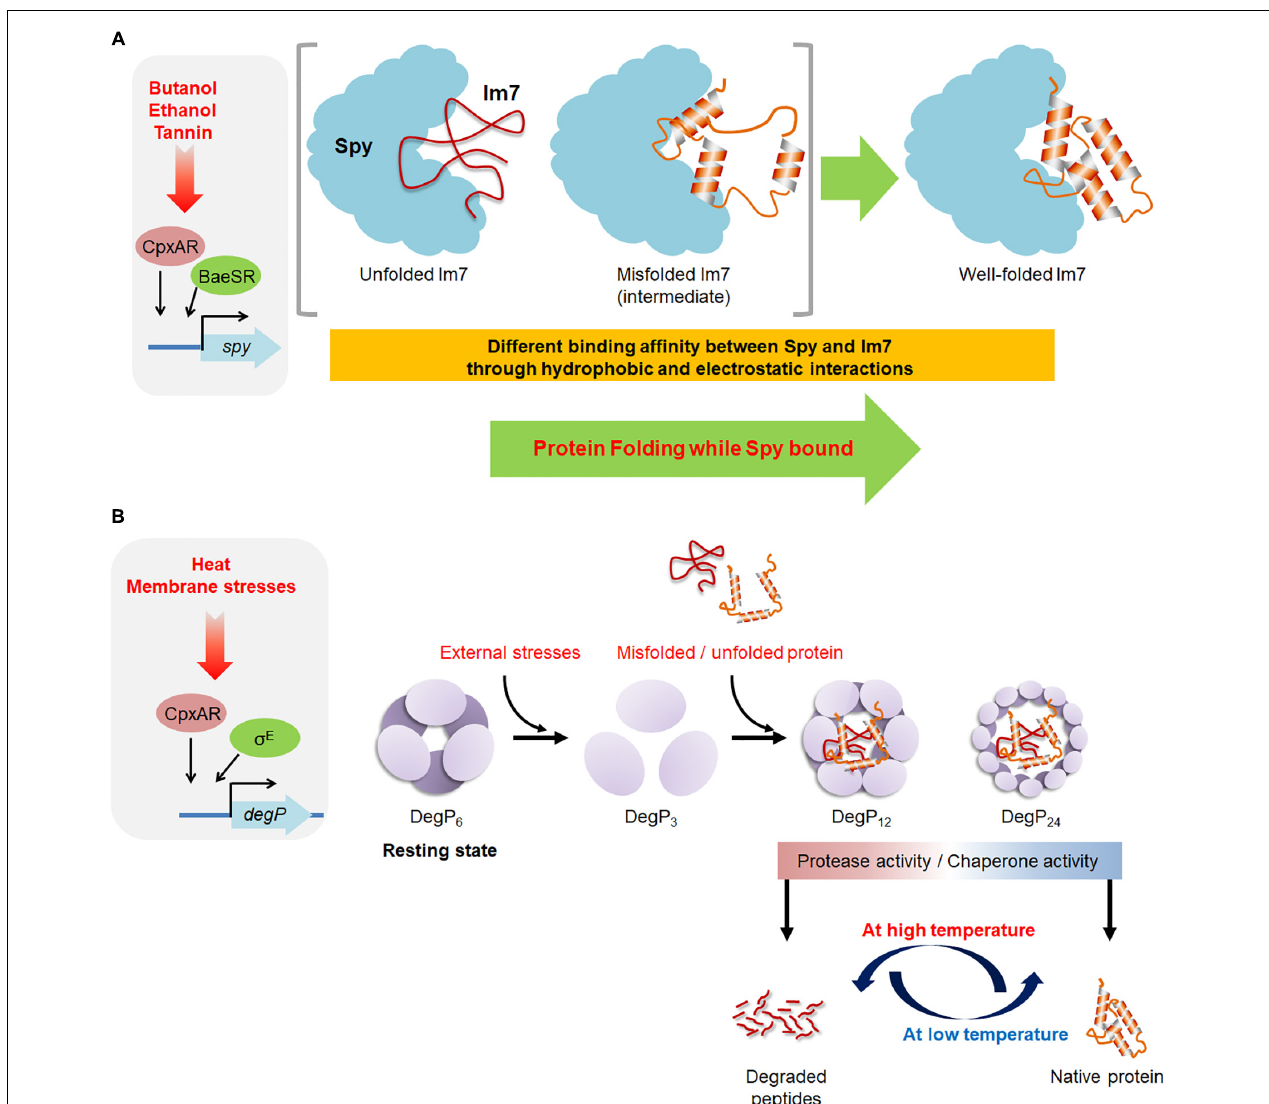
FIGURE 2 | An overview of the molecular mechanisms of Spy and DegP. (A) The envelope-stress conditions occurring under butanol, ethanol, and tannin exposure induce the production of the chaperone Spy, which binds to misfolded or unfolded substrates by electrostatic and hydrophobic interactions. Spy prevents further aggregation of the substrate and enables proper folding of the substrate while it is bound to Spy. (B) DegP exhibits both the chaperone and protease activity. The hexameric form of DegP is a resting state. The exposure to external stresses, the hexameric DegP presumably dissociated to trimers, which are a basic building unit for the formation of large cage-like structures. The 12- and 24-mer of cage-like DegP complexes can encapsulate bound substrates for its chaperone and protease activity. The stress-induced conformation changes of DegP and the folding state of the bound substrates are thought to be involved in determining the fate of DegP as a chaperone or